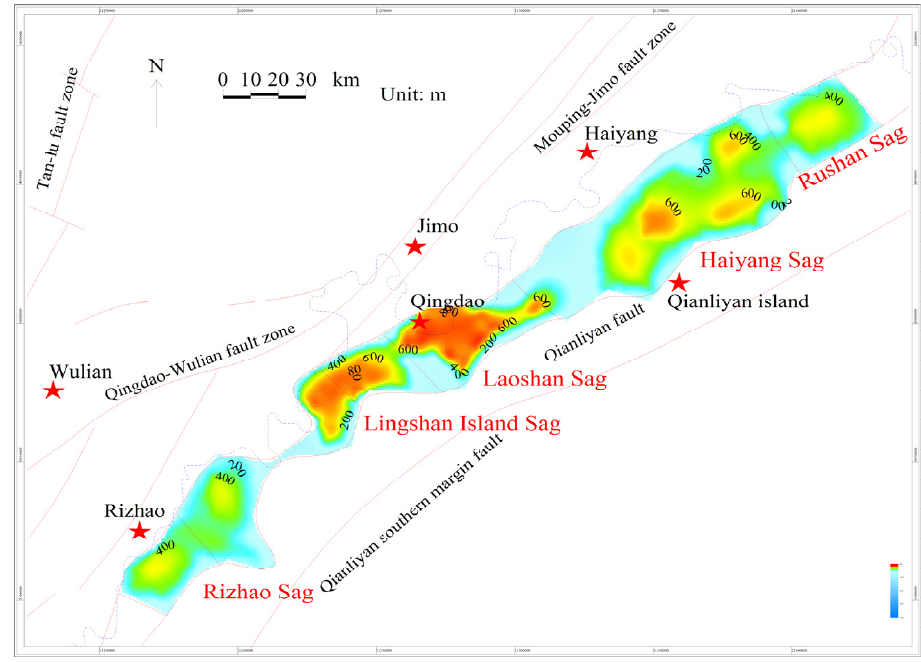
Figure 4. Contour map of the mudstone thickness of the Laiyang Formation in the Ri-Qing-Wei Basin.